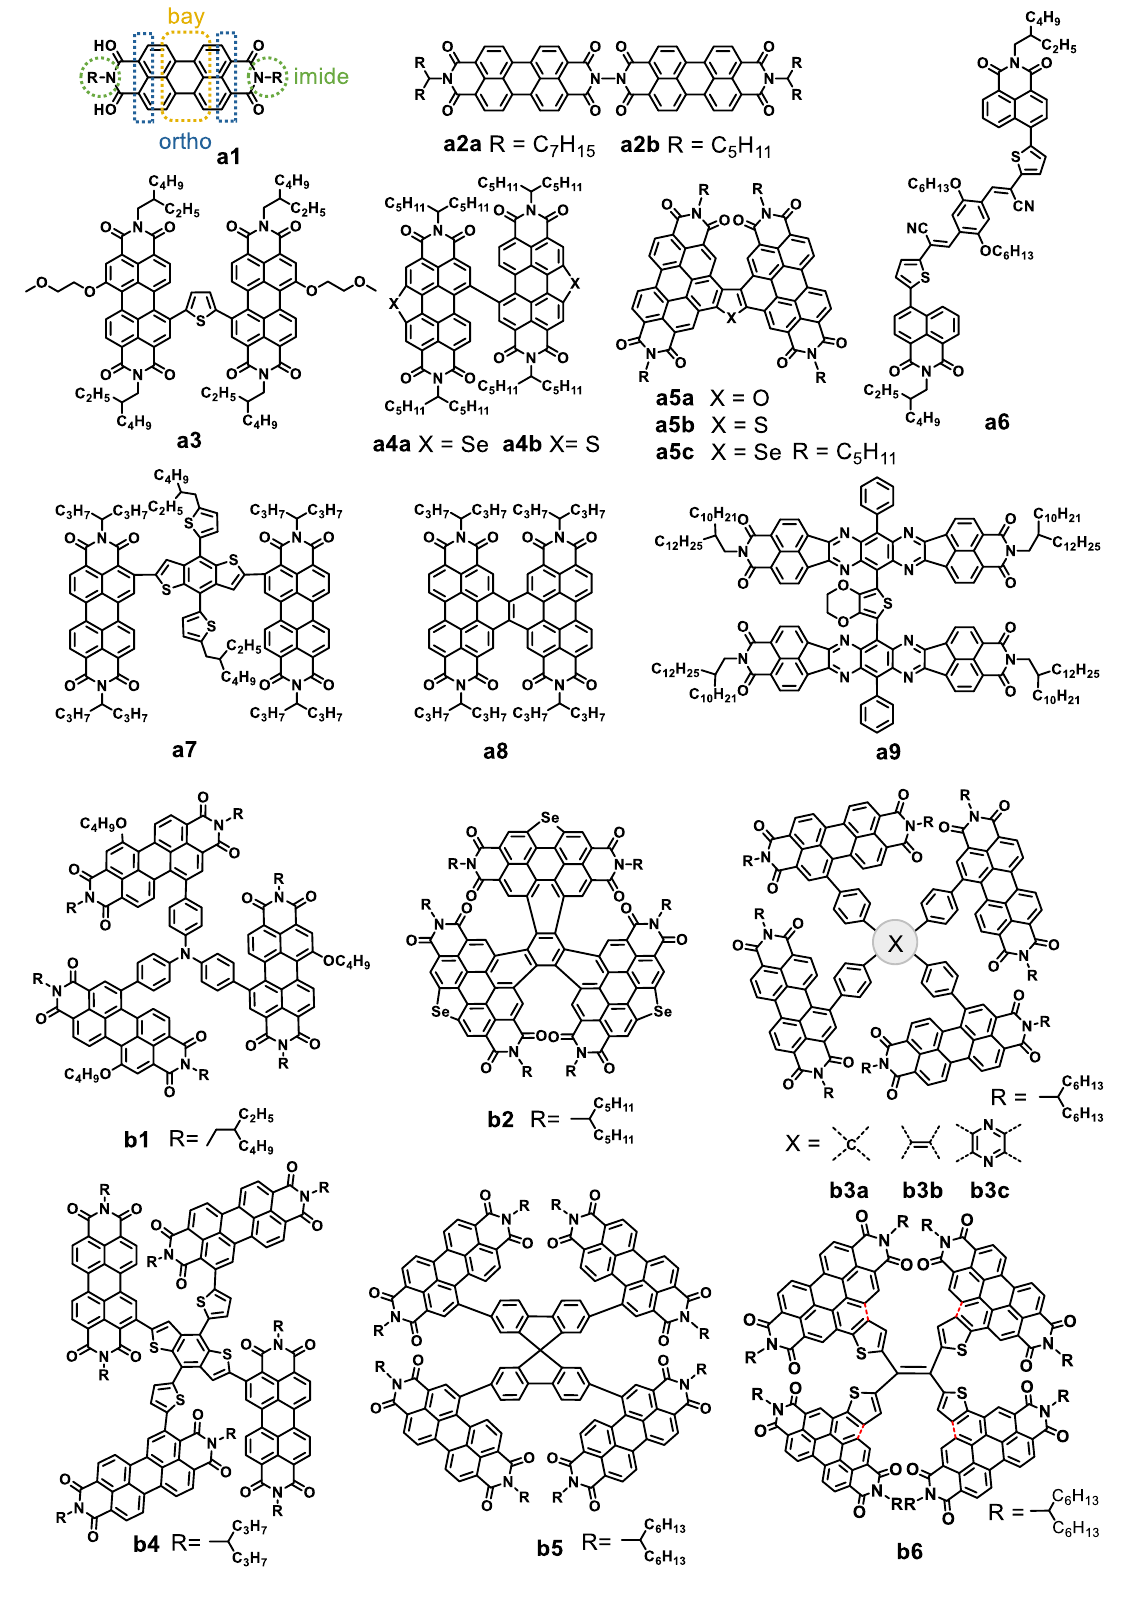
Fig. 2 Chemical structures of twisted and star-shaped PDI based